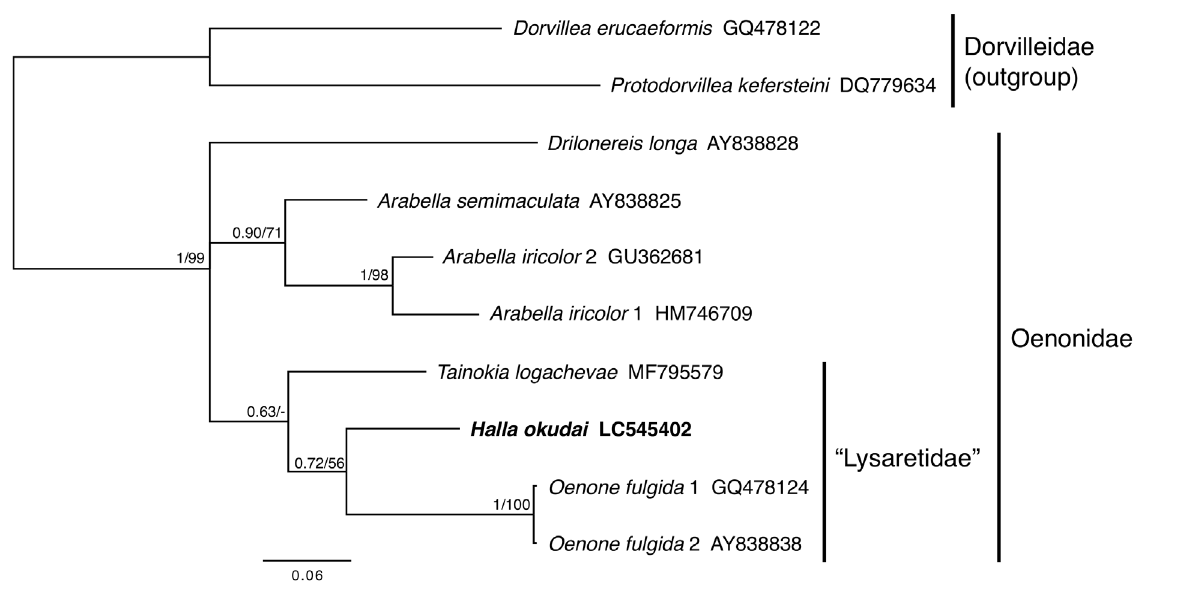
Figure 3. Bayesian phylogeny of Oenonidae based on 16S rRNA gene sequences (353 characters). Species names are followed by GenBank accession numbers. The numbers above the branches indicate posterior probability, followed by percentage of maximum likelihood bootstrap values above 50% (a hyphen represents <50%). Halla okudai , whose nucleotide sequence was newly obtained, is shown in bold. “Lysaretidae” has been synonymized with